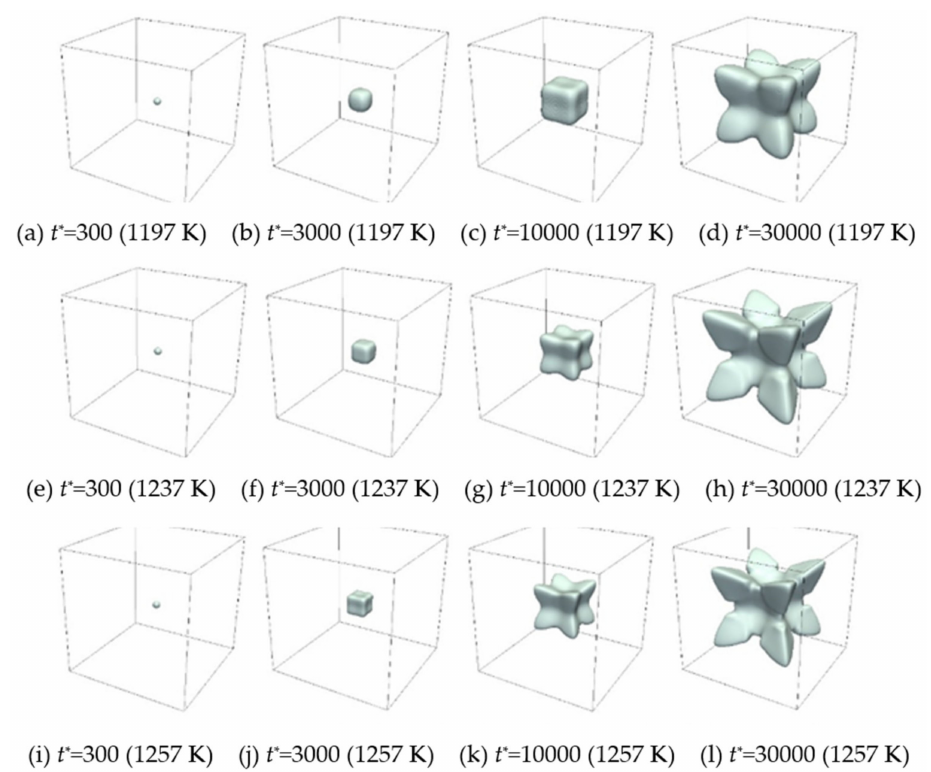
Figure 16. Morphological evolution of the iron-rich single precipitate in Cu-Fe system at different temperatures obtained in phase field modelling. Initial configuration contains an iron pure spherical nucleus of radius R = 4 ∆ x